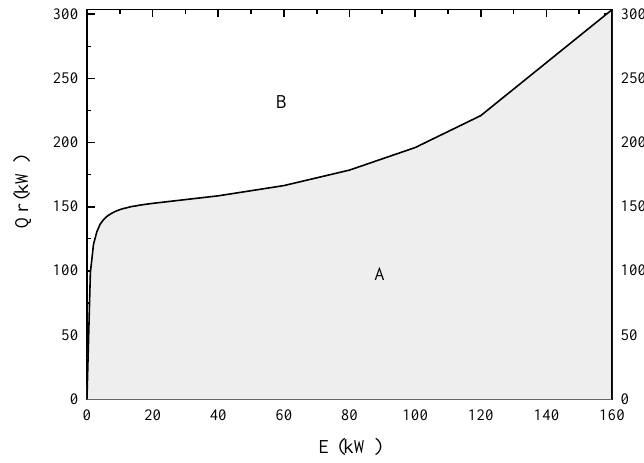
Figure 2. Heating and electric output in the gas turbine.